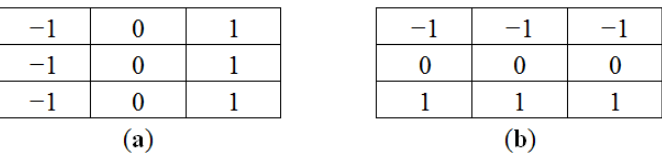
Figure 8. Directional filter. ( a ) x -direction; ( b ) y -direction.